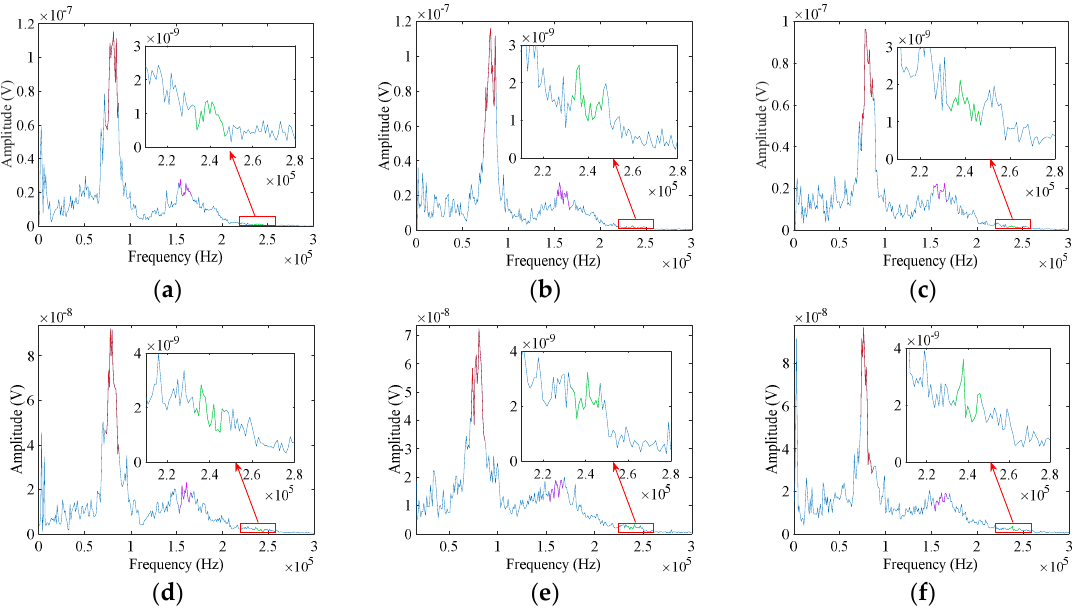
Figure 10. Hilbert marginal spectrum processed by WPT+HHT of different delamination damages. ( a ) 0 mm; ( b ) 4 mm; ( c ) 8 mm; ( d ) 12 mm; ( e ) 16 mm; ( f ) 20